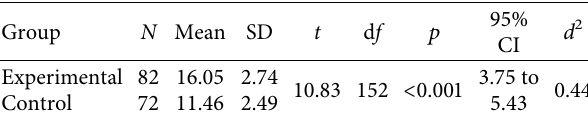
Table 2: Independent sample t -test statistics for testing the mean difference in the performance scores of experimental and control group students.